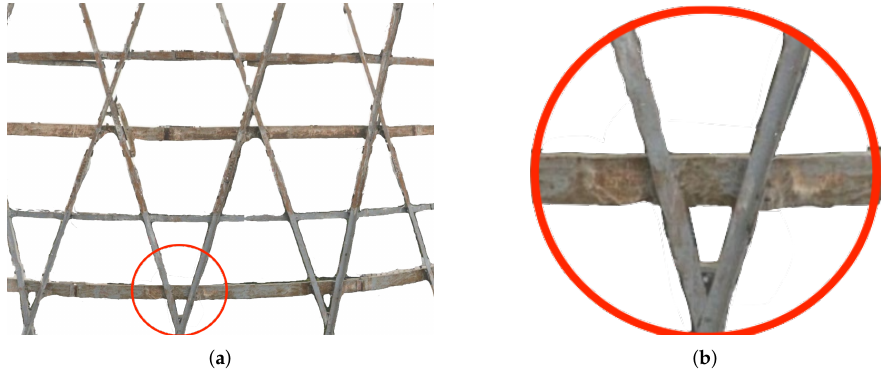
Figure 16. Textured fragment of the tower 3D model ( a ) with up-scaled detail ( b